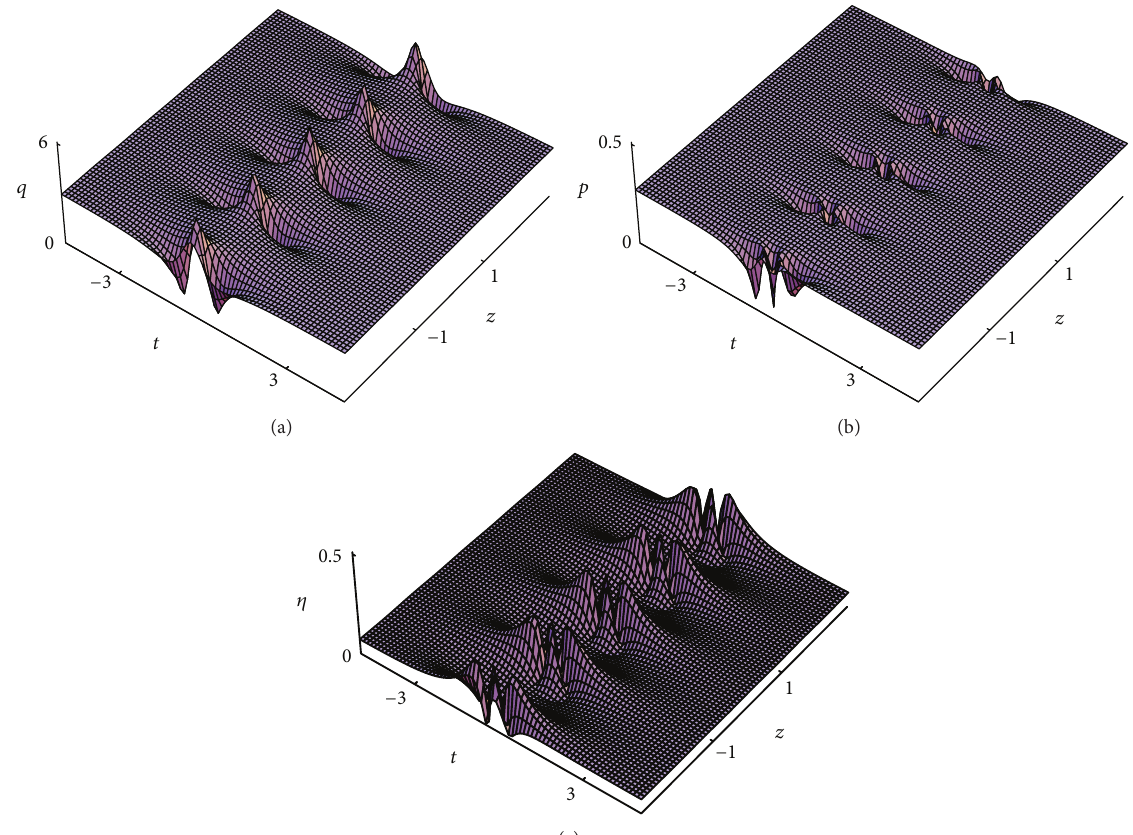
Figure 2: The parameters adopted here are 𝜅 𝑠 = 2.3 , 𝑞 𝑐 = 1 , 𝜅 𝑐 = 3 , 𝜔 = 1 , and 𝜏 = 0.1 .